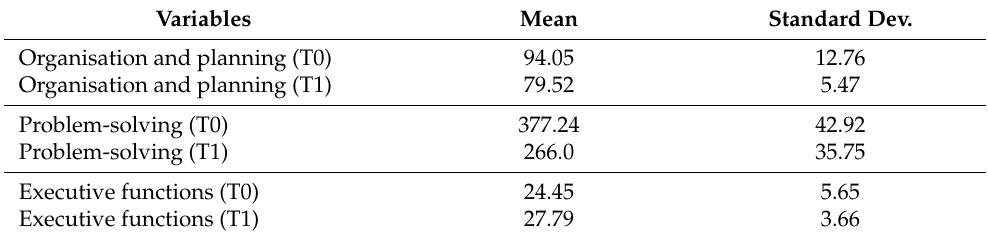
Table 9. Descriptive analysis of the averages of the scores at the variables of TOL test at T0 and T1. Variables Mean Standard Dev.